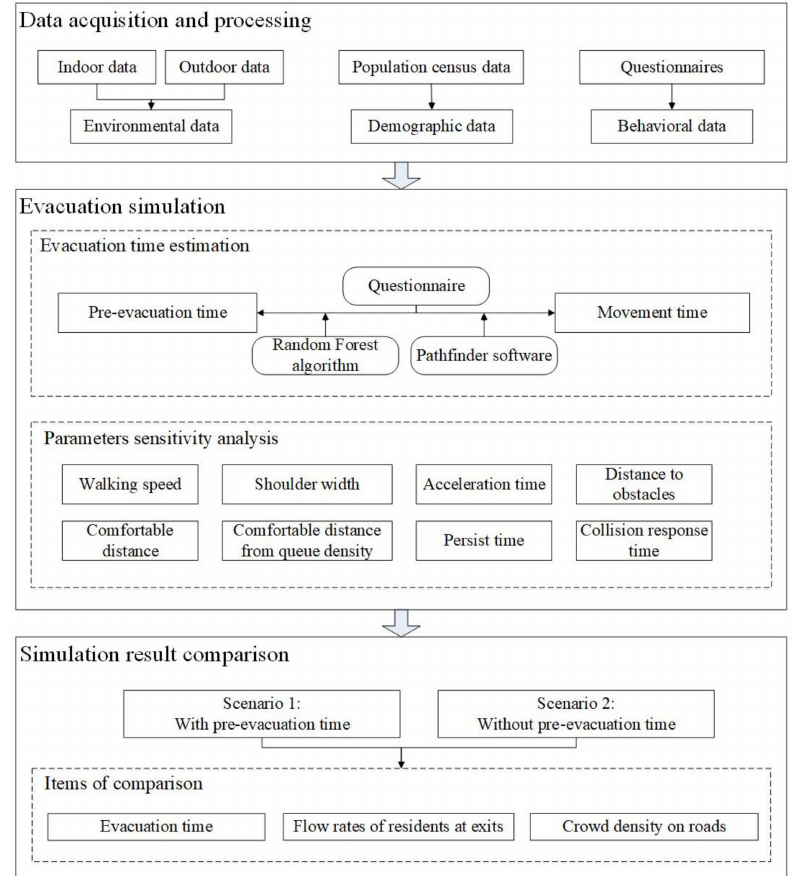
Figure 1. Framework of the proposed method for evacuation simulations based on pre-evacuation time